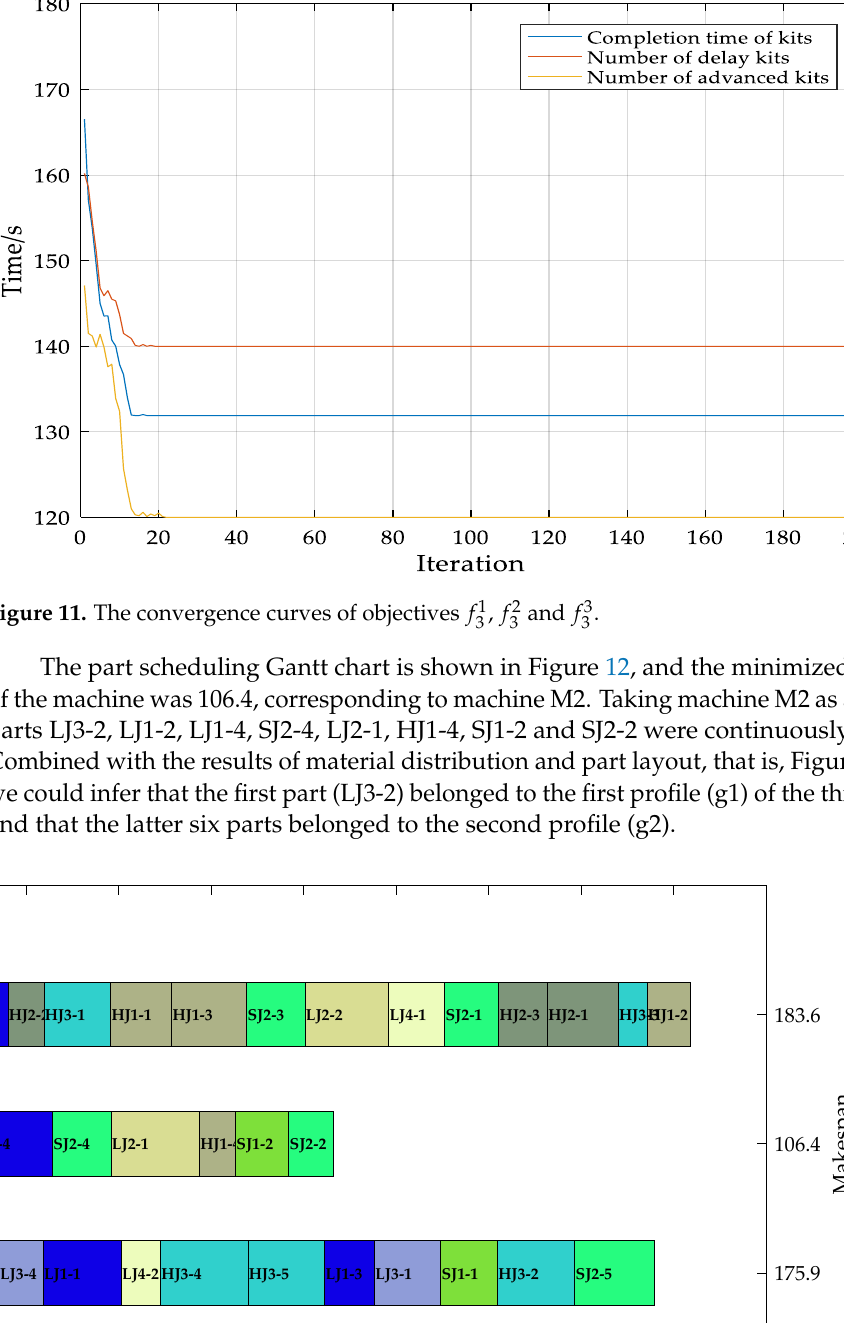
Figure 10. Gantt chart of optimal part nesting.